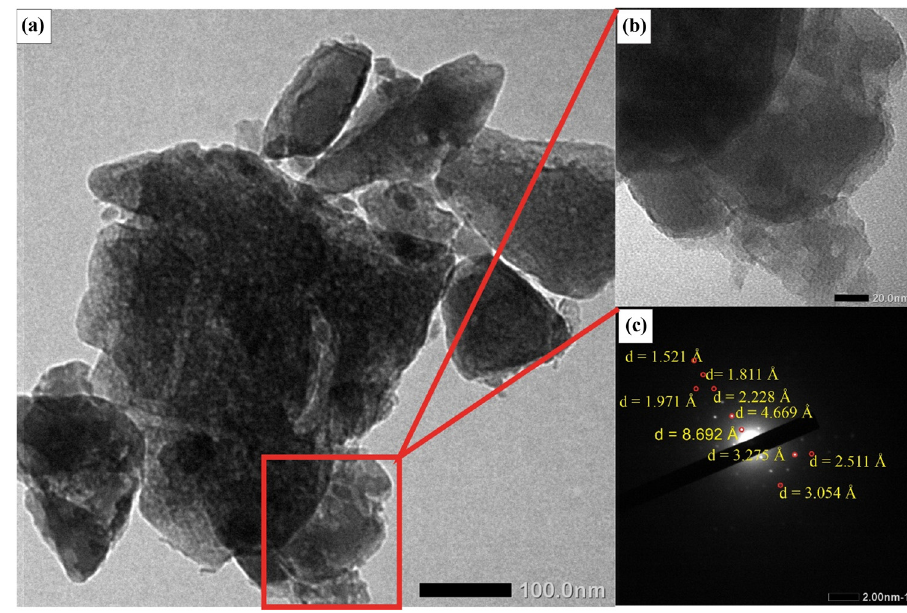
Figure 8: TEM Image of Br catalyst with magni fi cation on ( a ) 40,000 × , ( b ) 150,000 × , and ( c ) di ff raction